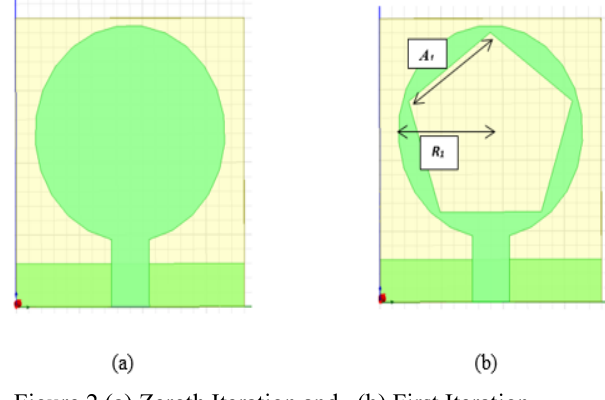
Figure 2 (a) Zeroth Iteration and (b) First